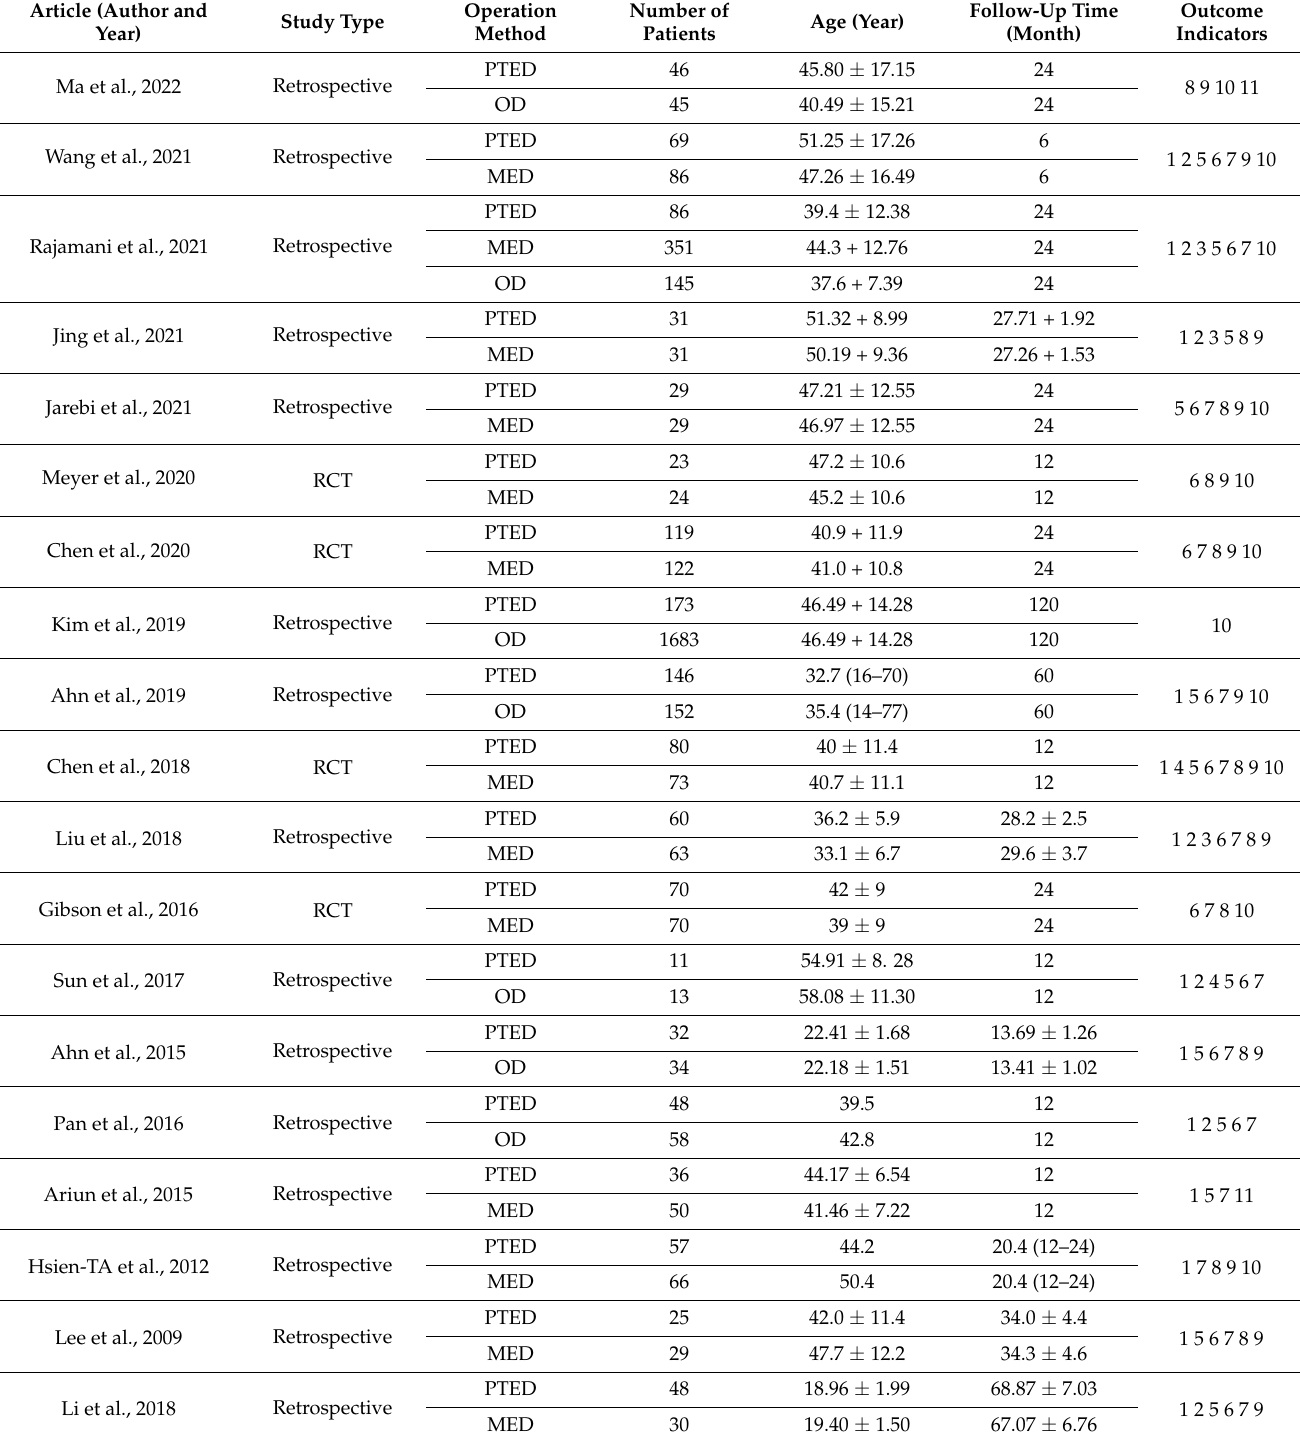
Table 1. Basic information of the